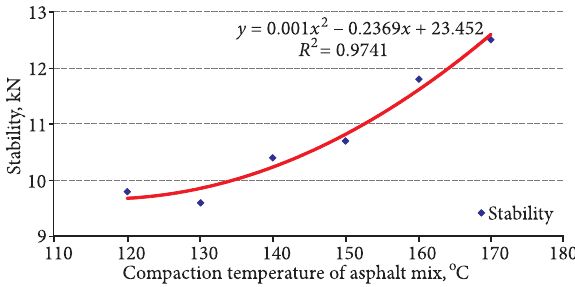
Fig. 5. Relationship between compaction temperature and Marshall Stability